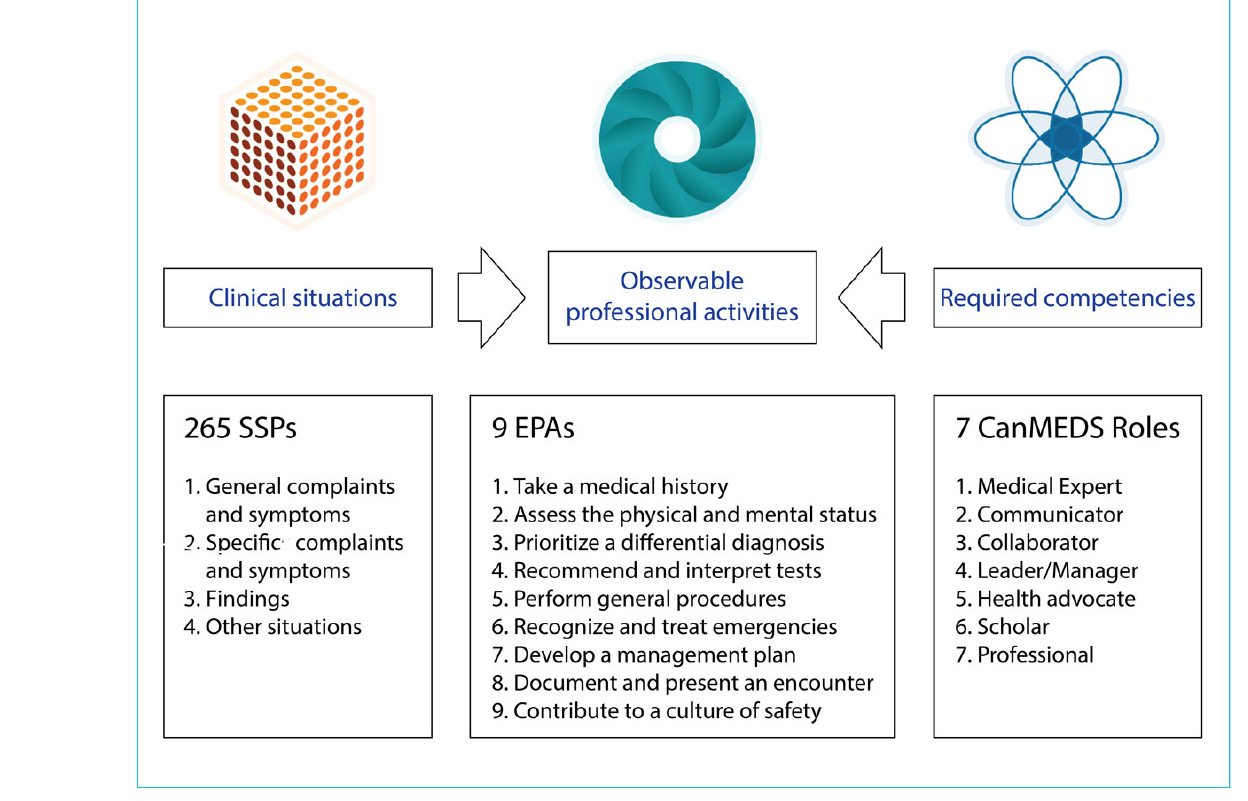
Figure 1: PROFILES is composed of three main sections: CanMEDS roles, entrustable professional activities (EPAs) and situations as start- ing point